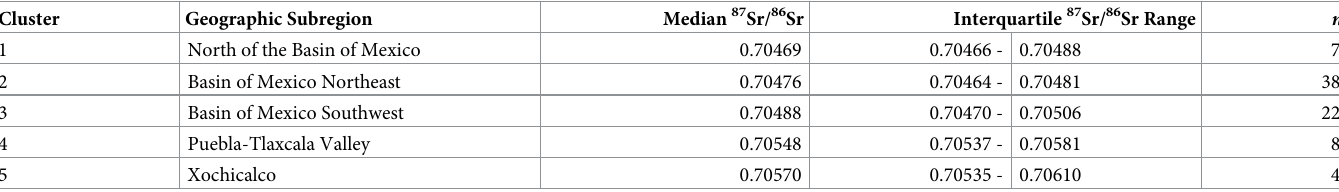
Table 2. 87 Sr/ 86 Sr medians and interquartile ranges for central Mexican subregions identified through k-means cluster